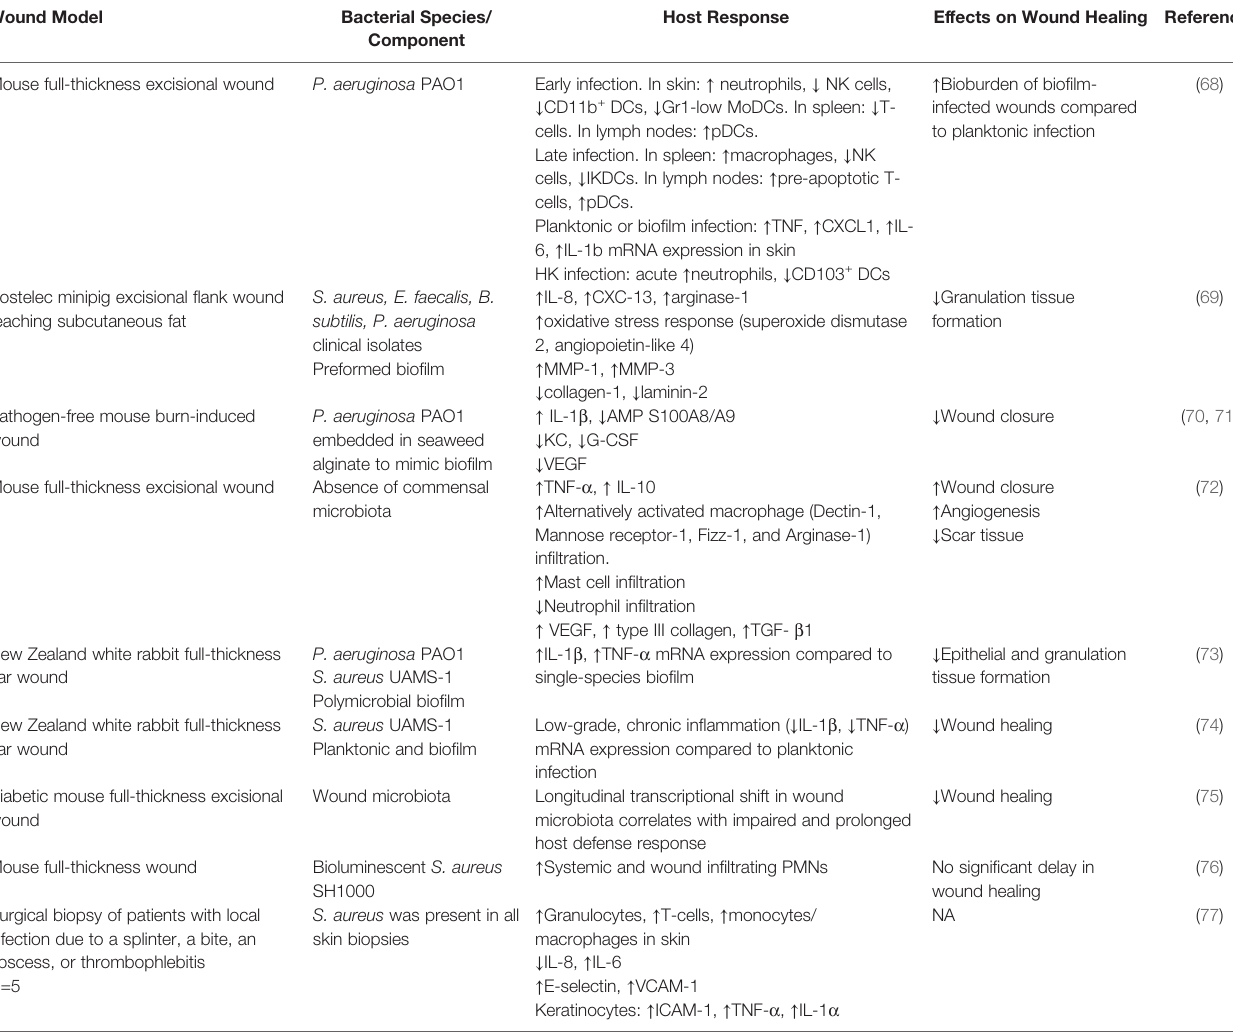
TABLE 2 | Summary of studies characterizing host immune responses to bacteria and bacterial bio fi lms in wound